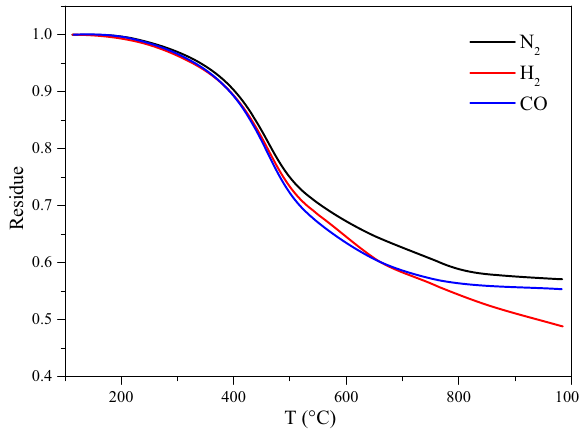
Fig. 3 TGA profile for coal pyrolysis in different atmospheres [mass of coal: * 30 mg; TGA operation condition: heating rate: 40 (cid:3) C/min from 105 to 1000 (cid:3) C; carrier gas and its total flow rate: 100% N 2 , 50%